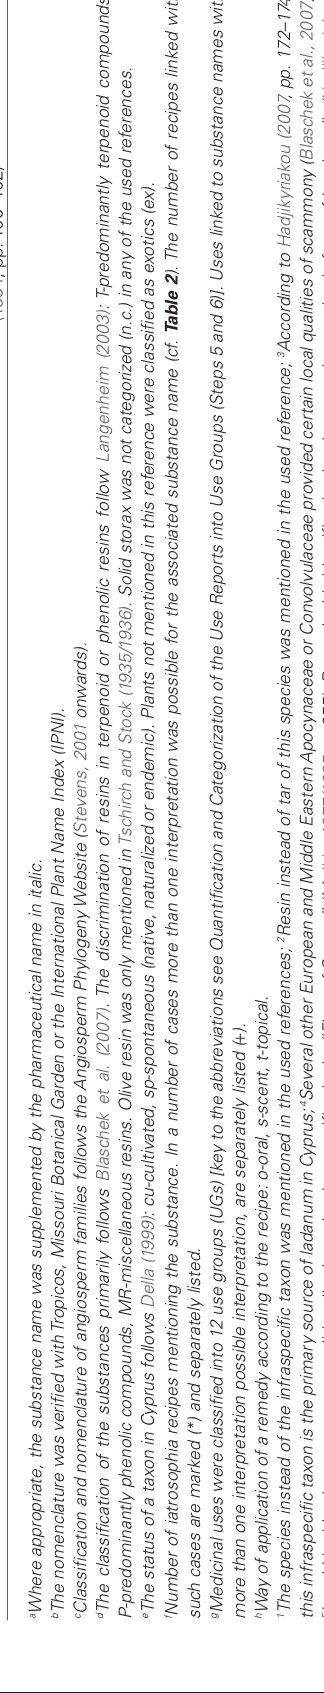
commerce for the island (Thiselton-Dyer, 1885; Tschrich and